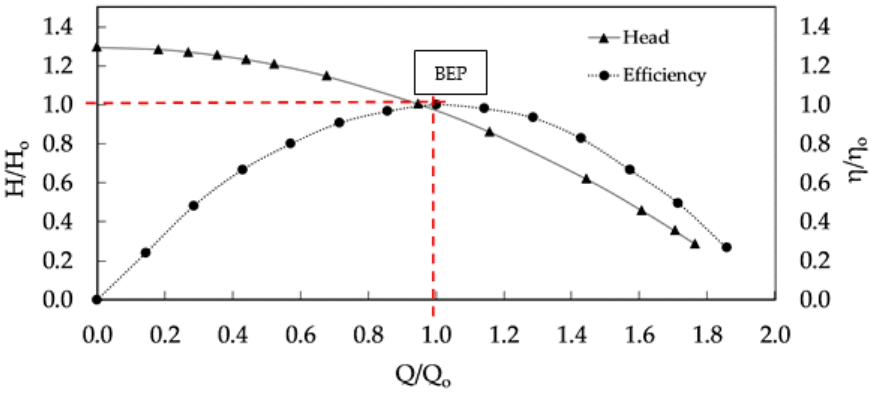
Figure 11. Dimensionless pump curves for the rotational speed of 2950 rpm.